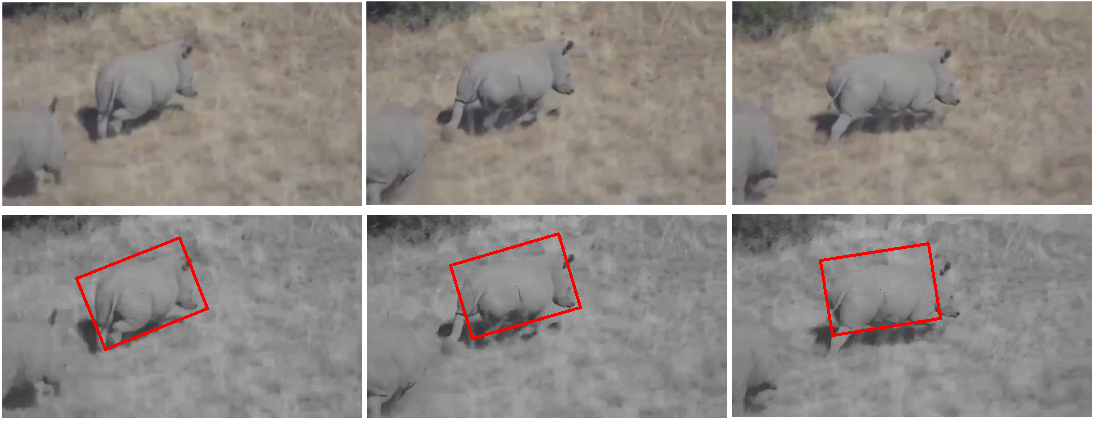
Figure 6. Visual rhino